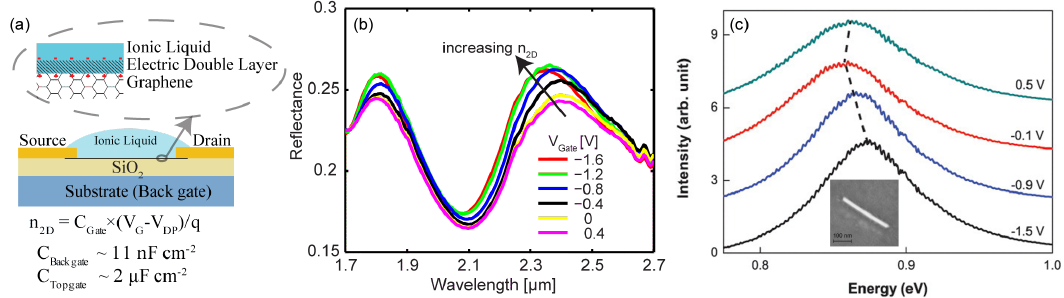
Figure5: (a)Schematicofdifferentgatingmechanismsforgraphene.Ionictopgatesupportshighersheetcarrierdensitythantheconventional Si back gate due to higher capacitance; (b) modulation of Fano resonant structures at NIR wavelengths; and (c) voltage dependent scattering spectrum from a single gold nanorod covered with graphene. Figures (b) and (c) adapted with permission from references [62] and [61], respectively. Copyright (2012–2013) American Chemical